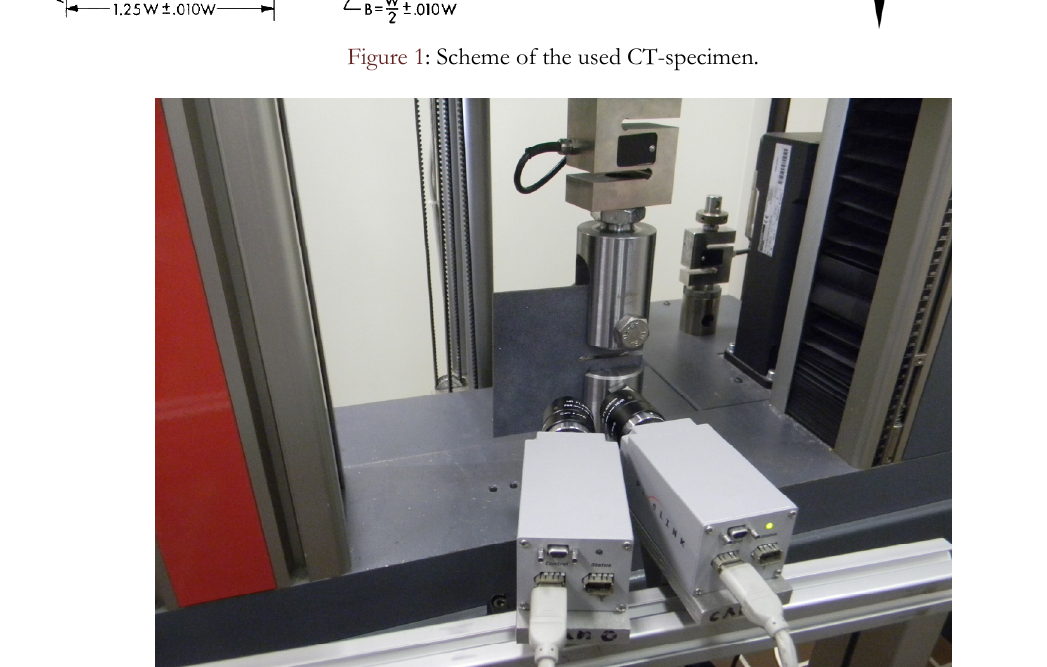
Figure 2: Experimental